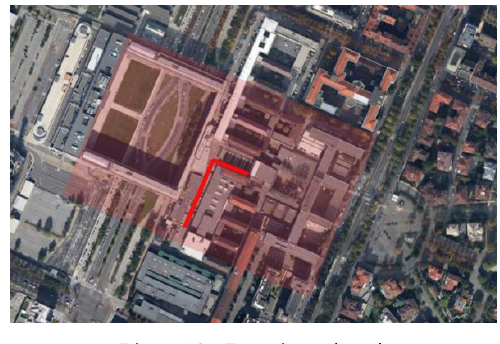
Figure 18 - Test site and track